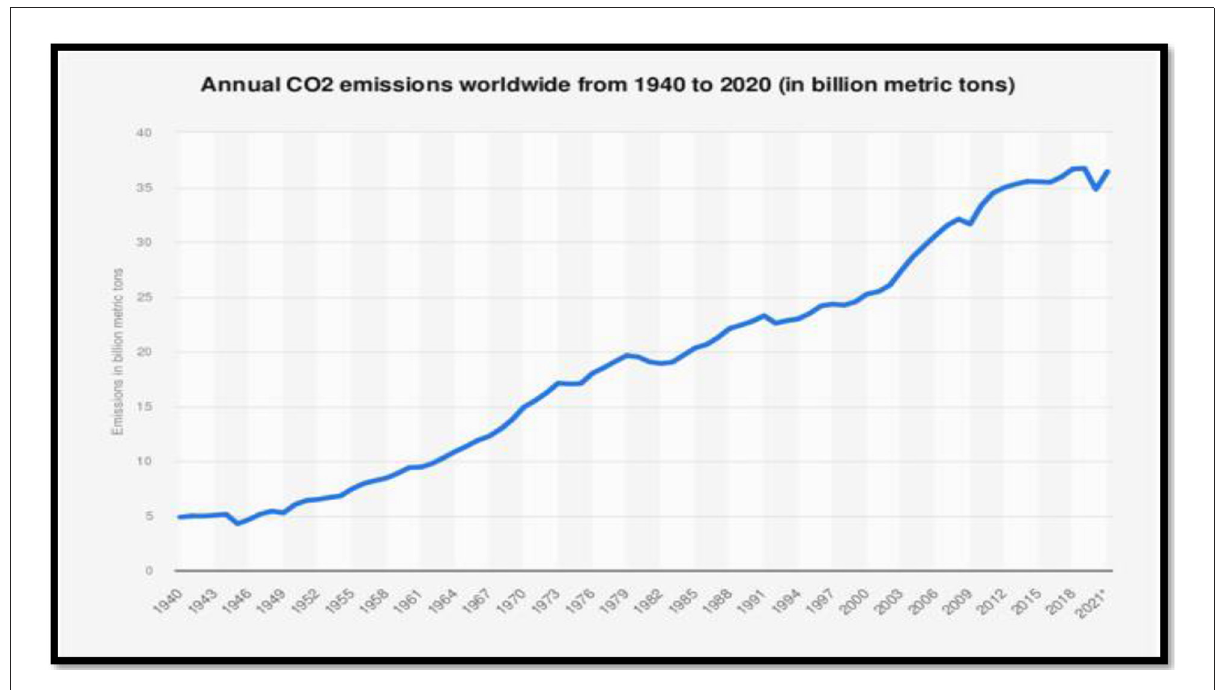
FIGURE3 Annual CO 2 emissions in billion metric tons from 1940 to 2020. Source: Author’s analysis, Statista (2022a)